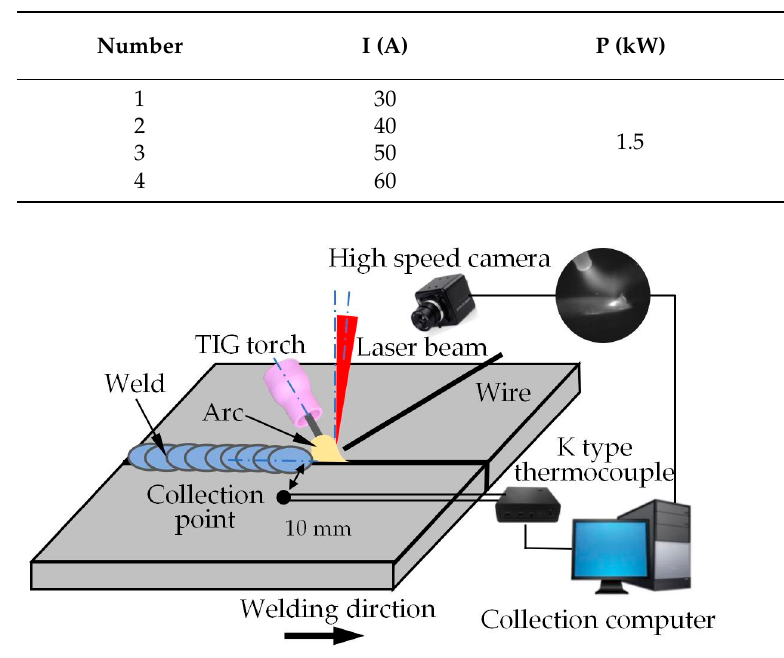
Figure 3. The temperature and image acquisition system.